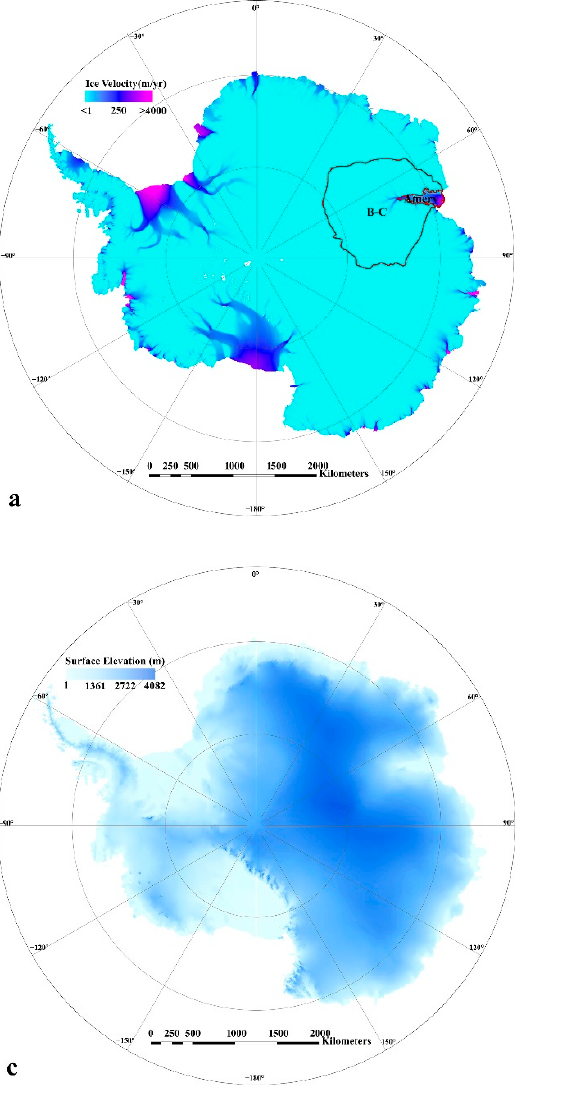
Figure 4. Overview of experimental data. ( a ) PAIVM. ( b ) Antarctic boundaries. ( c ) Bedmap2 surface elevation. ( d ) MOA2009.